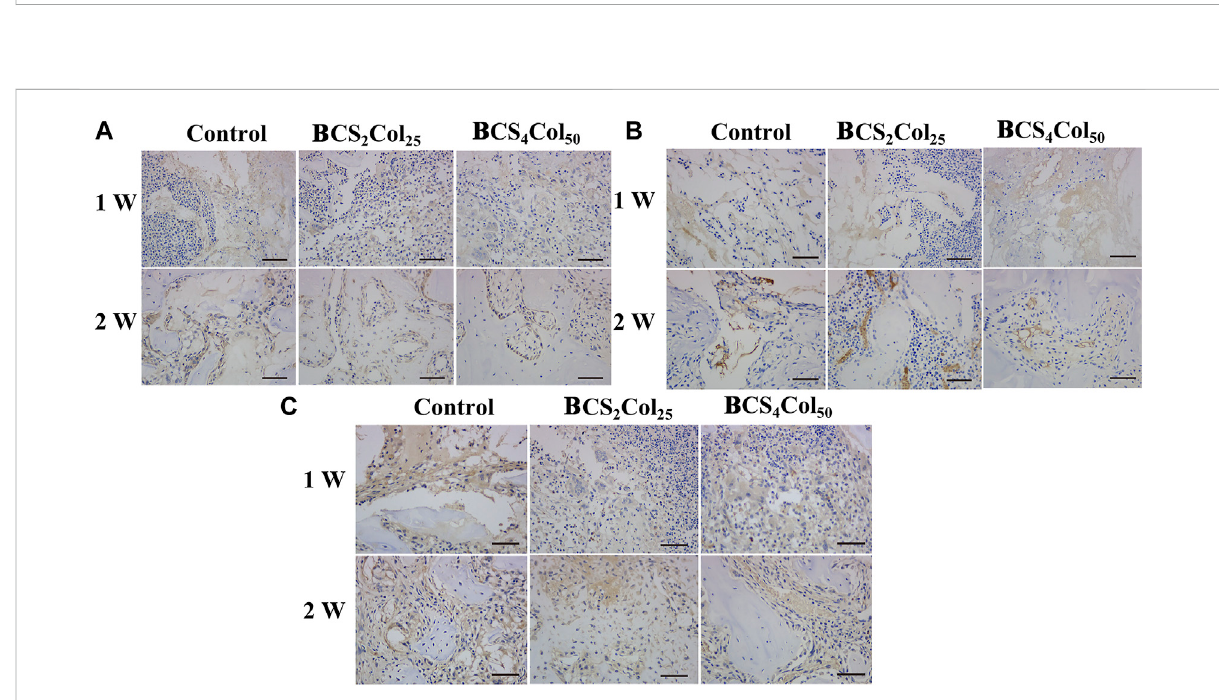
FIGURE 9 Representative immunohistochemical images of the femoral defects in rats at week 1 and week 2 postoperatively. (A) IL-1 β , (B) IL-6, and (C) TNF- α .The scale bar is 50 μ m. (changed the fi gure of IL-1 β , BCS2Col25,